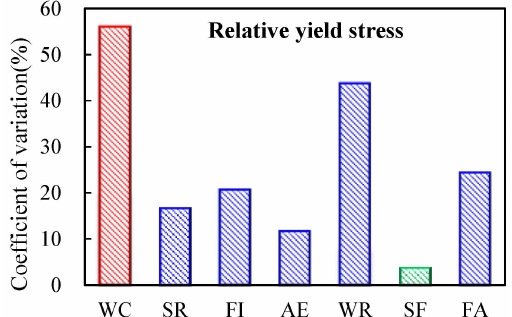
Figure 19. Difference analysis of factors on yield stress.